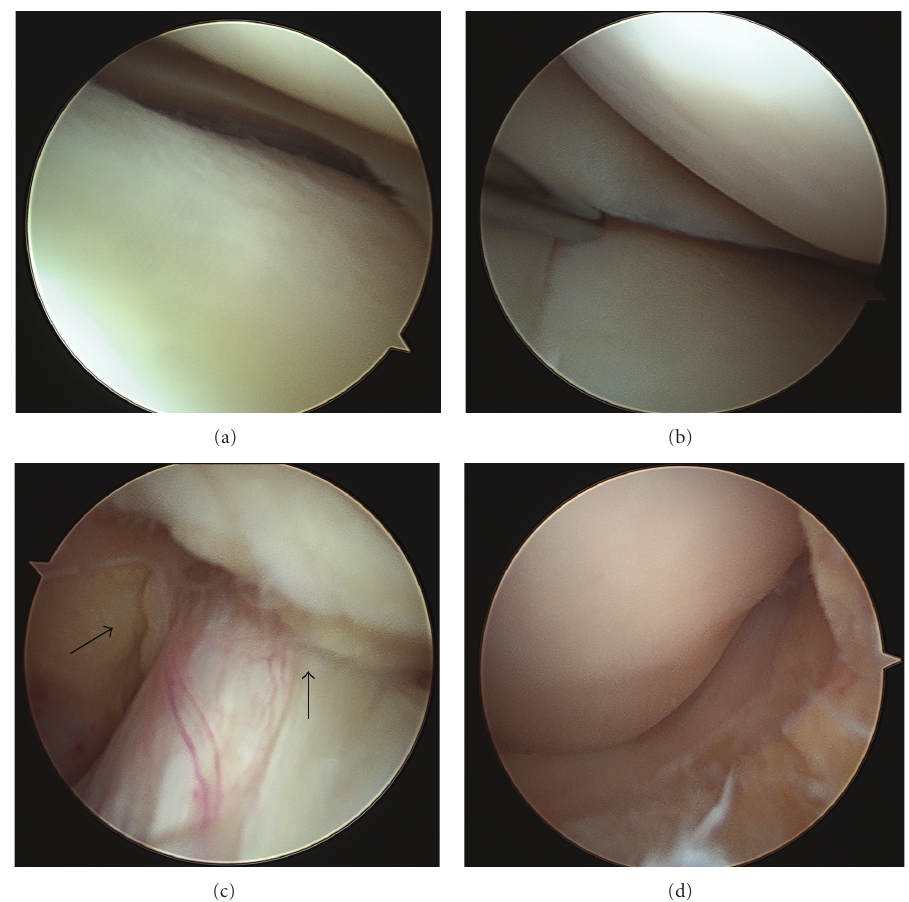
Figure 5: Intraoperative images displaying normal lateral (a) and medial (b) menisci, intact ACL (c) surrounded by debris, and the view of the anterior/lateral knee joint following extensive shaving into the fat pad